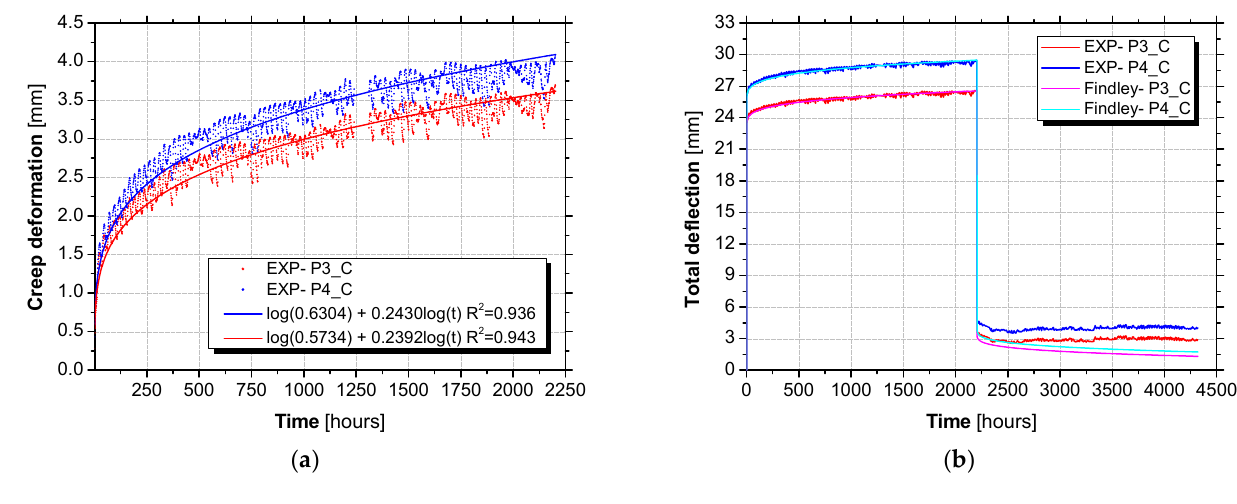
Figure 15. Findley’s power law values adjusted to the experimental values: ( a ) creep deformation at loading stage (log10 plot) and ( b ) total deformation at loading and unloading stages. Table 10. Coefficients (cid:1865) and (cid:1866) calibrated from the experimental tests. Specimen